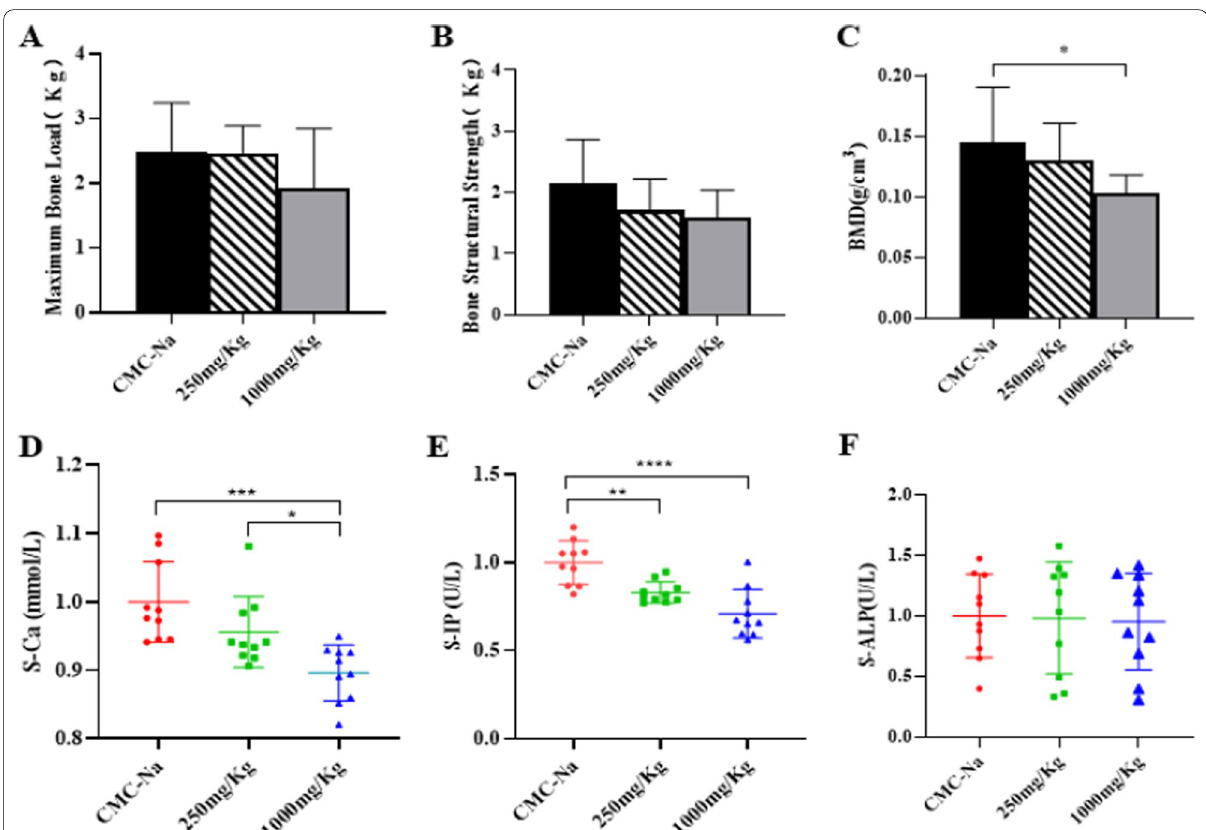
Fig. 1 After 6 months of LPZ gavage, the right femurs of male and female mice were scanned by micro-CT to calculate BMD (n mice were randomly sacrificed, and blood was collected to examine bone and serum biochemical indicators (n strength properties. C BMD of the right femur. D – F Bone serum biochemical